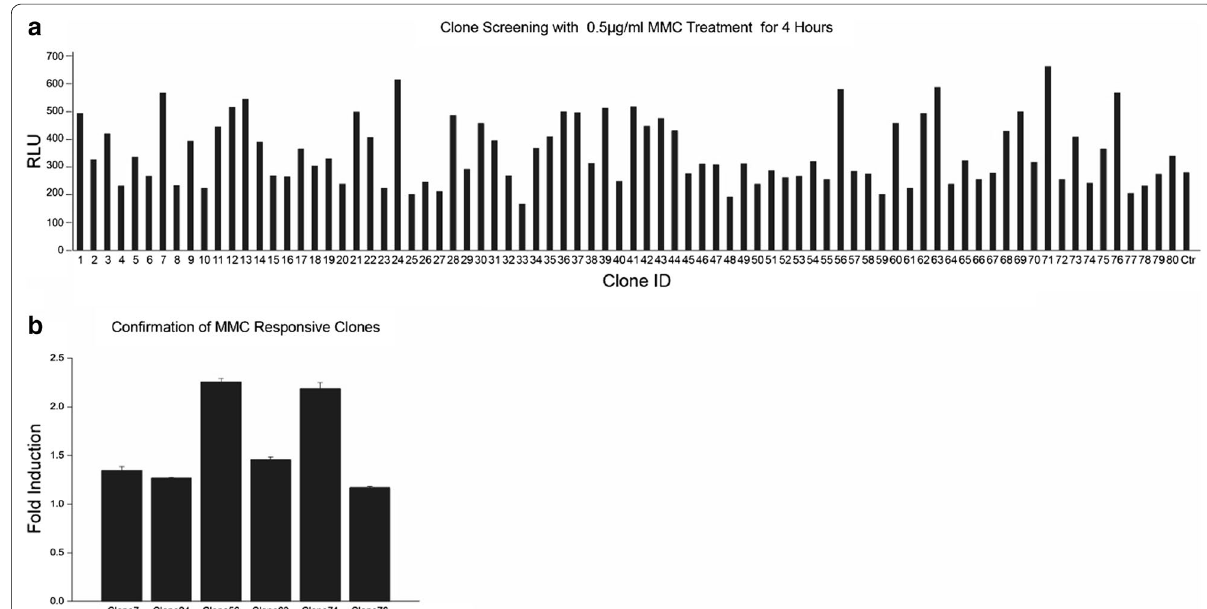
Fig. 3 Directly functional screening of mitomycin C-responsive clones. Eighty clones randomly selected from generated library, cultured them with 0.5 μM mitomycin C treatment for 4 h, and subject to luciferase analysis ( a ). Six clones with luciferase activities > 550 RLU were selected for induction assay with and without mitomycin C treatment ( b )